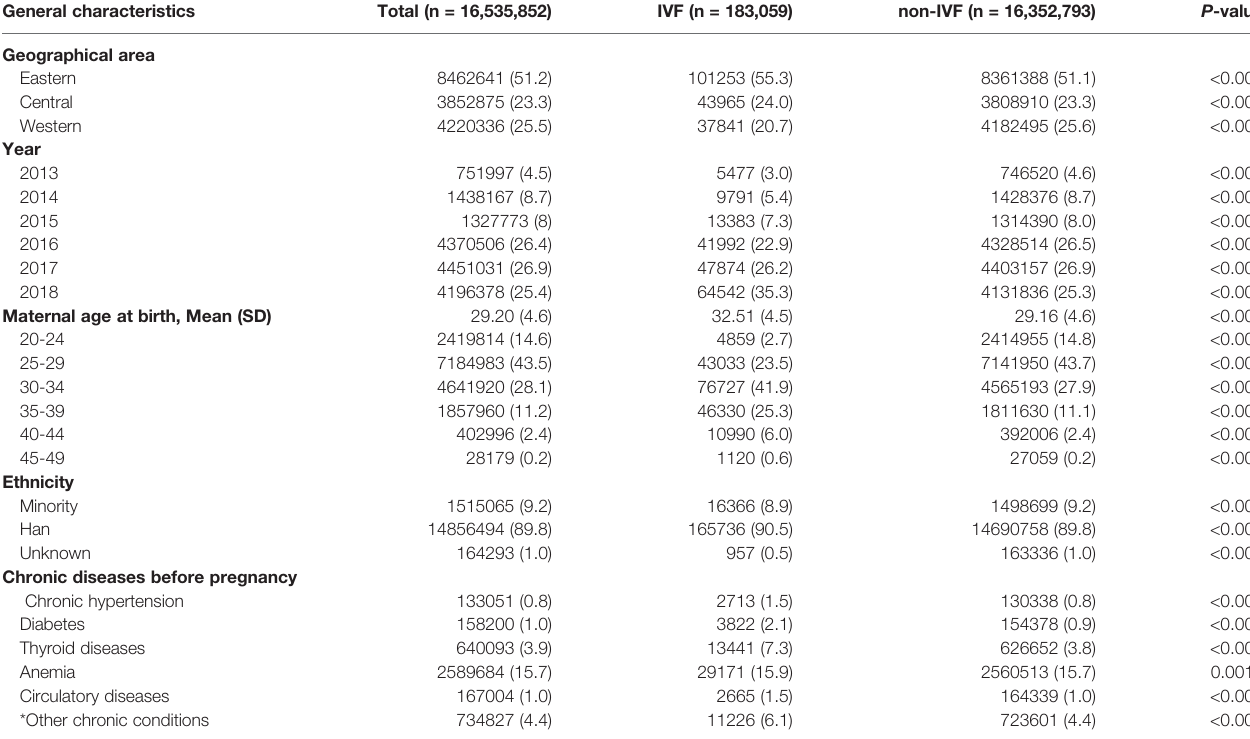
TABLE 1 | The general characteristics of study population in this study. General